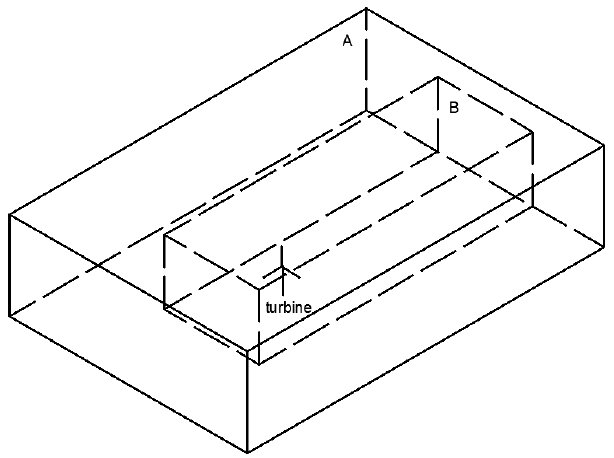
Figure 6. The simulation domain of single wind turbine.